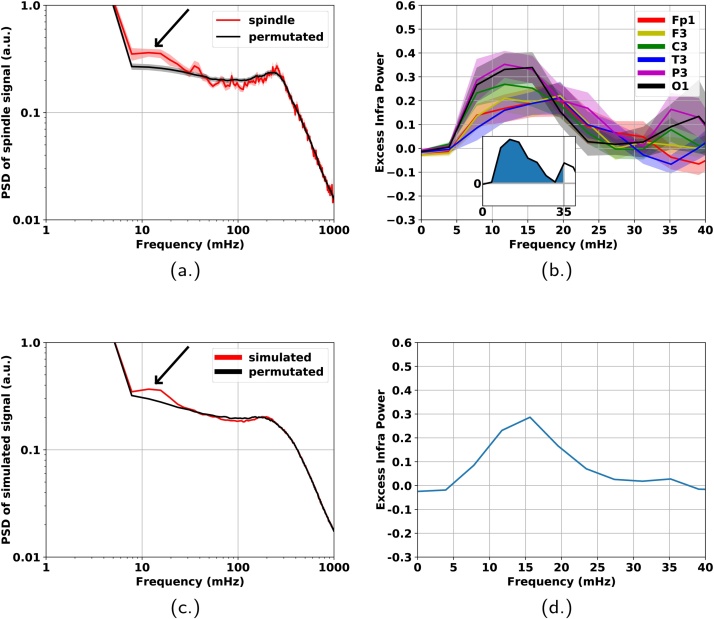
Infra oscillation of fast spindle activity (13–15 Hz) as measured in the power spectral density of the binary spindle signal (see Fig. 1). PSD of the binary spindle signal is compared to that of a surrogate signal obtained from the binary spindle signal by randomly permutating on and off states and the separations in between (see Section 2.2.4). (a) Representative example (P3-A2 channel, NREM2, fast spindles, average across 34 subjects (shaded area = SEM)) for the PSD of the spindle square signal and the corresponding reference signal (NREM2, fast spindles, average across 34 subjects, shaded area = SEM). (b) Excess infra power (EIP), i.e., relative difference between the PSD of spindle and permutated signal. Average of 34 participants. Shaded region illustrates the level of standard error. Inset: The positive (shaded) area between the abscissa and the curve limited to the 0–35 mHz region is also used as a measure of the EIP due to the infra modulation. It is referred to as integrated EIP. (c) PSD of simulated spindle signal (sequences of 100 events with intra event separations modulated at 13 mHz) and the corresponding permutated signal. Continuous lines correspond to the mean of a large statistical ensemble of 1000 similarly prepared simulations therefore standard error is not represented. (d) EIP for the simulated signal.